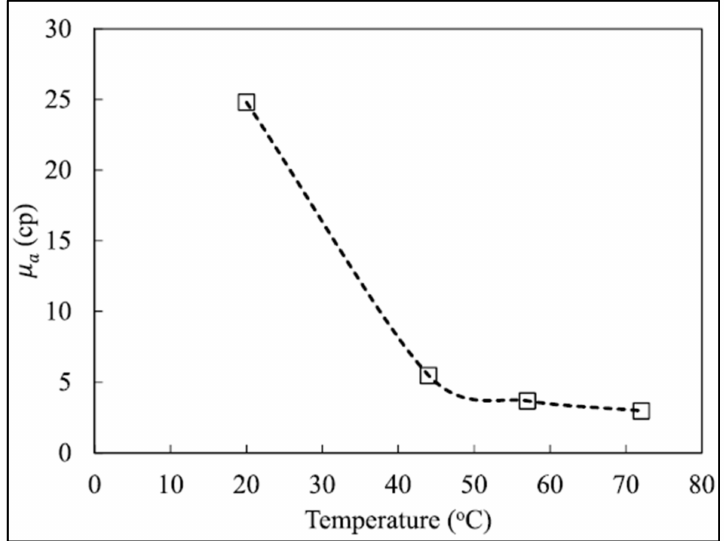
Figure 20. Effect of temperature on CO 2 foam apparent viscosity (Reprinted with permission from Fu & Liu, [56]). Copyright 2020, Elsevier B.V.